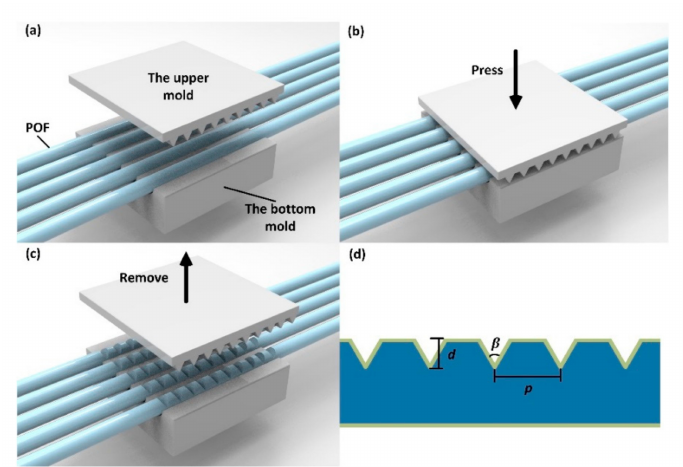
Figure 1. The schematics of the preparation of the sensor probes ( a ), ( b ), ( c ), and the V-groove structure on the plastic optical fiber (POF) ( d ), where d is the V-groove depth, β is the V-groove angle, and p is the V-groove pitch.